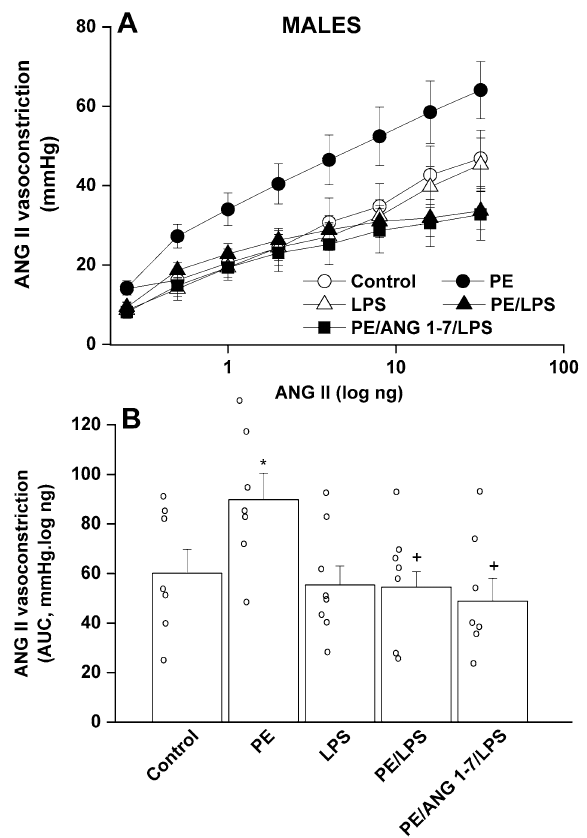
Figure 2. Effect of PE programming on cumulative vasoconstrictor response curves of Ang II ( A ) and AUCs of the Ang II cumulative vasoconstrictor response curves ( B ) measured 4 h post LPS challenge (5 mg/kg) in isolated perfused kidneys of adult male offspring. The influence of prenatal administration of Ang1-7 is also shown. Contractile responses were estimated as changes from basal renal perfusion pressure. Values are expressed as means ± S.E.M of 7–8 measurements. ANOVA followed by the Tukey’s post hoc was utilized to measure statistical significance. *P < 0.05 vs. “Control”, + P < 0.05 vs. “PE” in the same